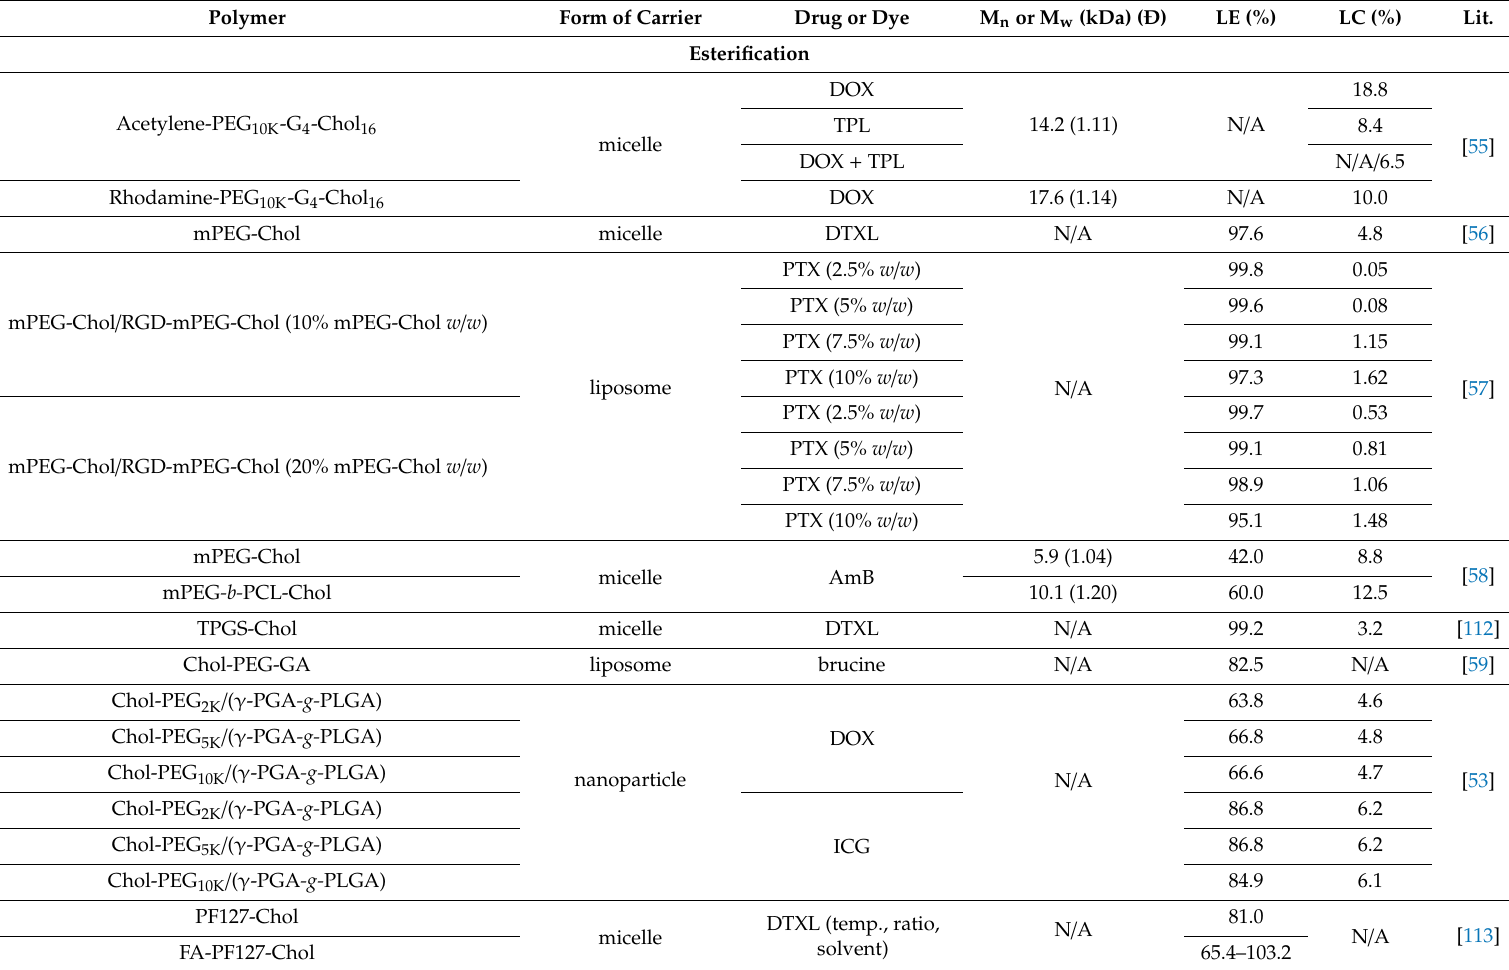
Table 2. Cholesterol end-capped polymers obtained by post-modification reported as